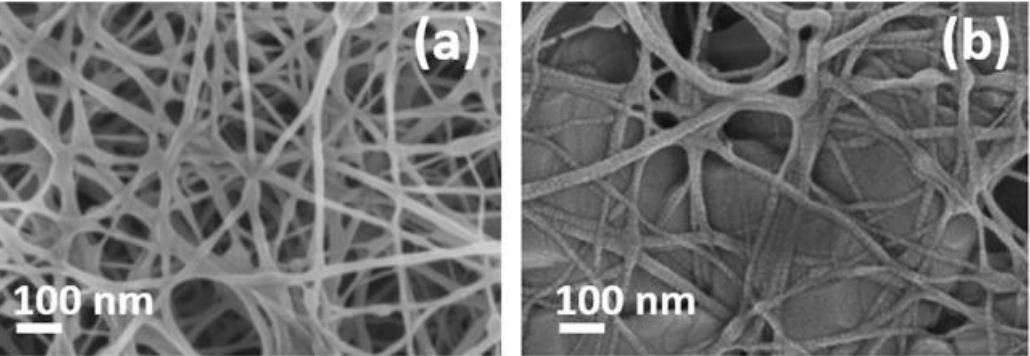
Figure 7. FESEM images of a PA6 NFs layer ( a ) before and ( b ) after the hydrolysis treatment.